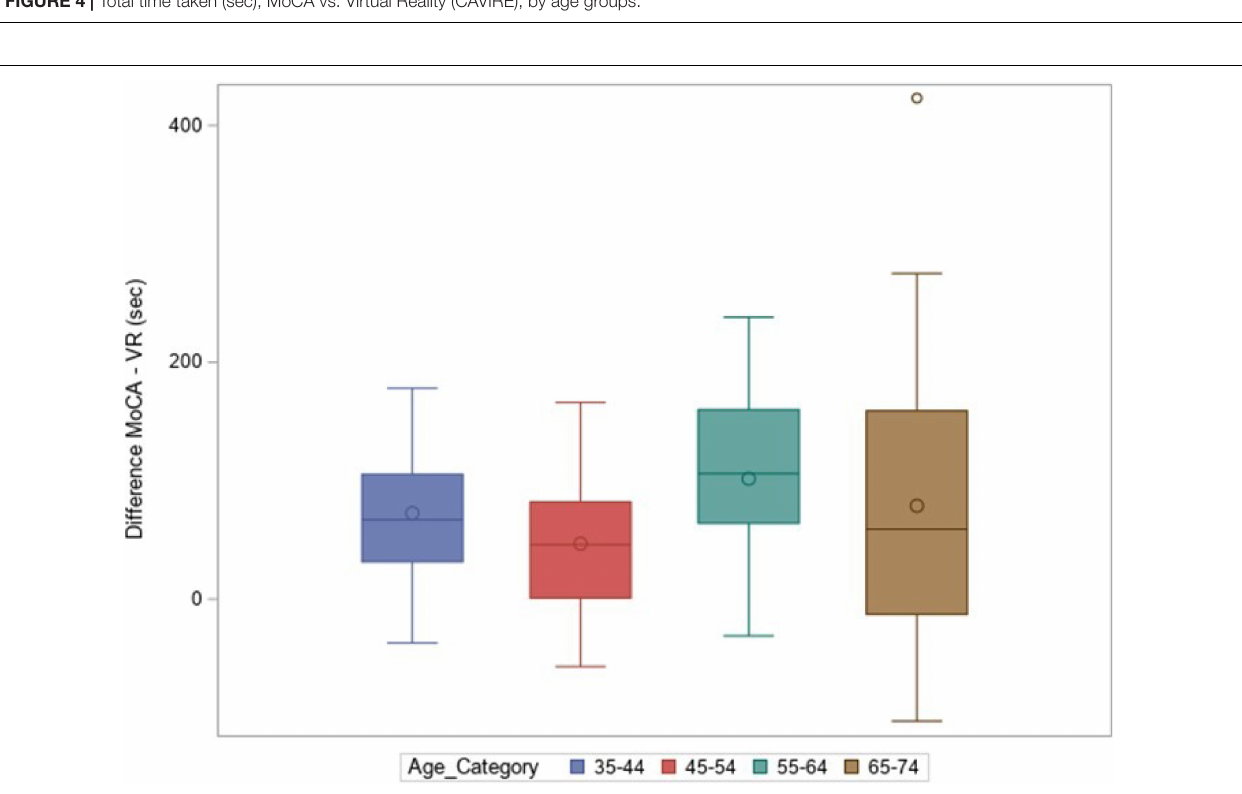
FIGURE 5 | Difference [MoCA—VR (CAVIRE)] in total time taken (sec).